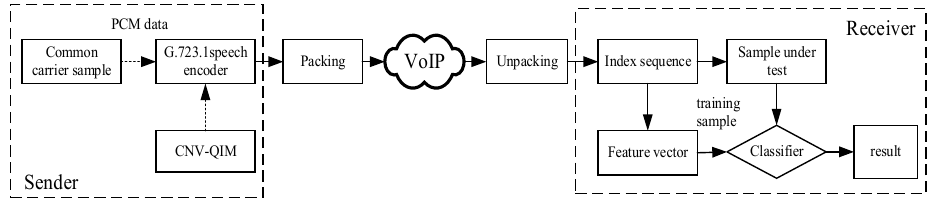
Figure 4. Experimental environment.